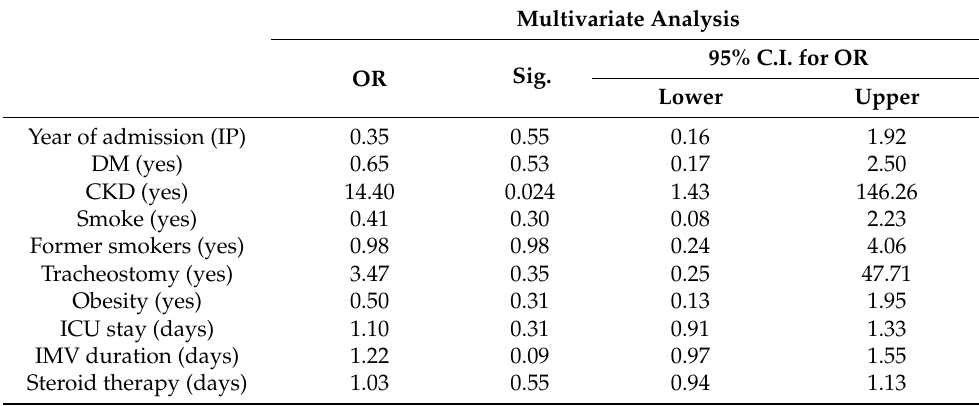
Table 4. Multivariate logistic regression analysis on risk factors associated with healthcare-associated infections, with outcome defined as presence/absence of HAIs during ICU